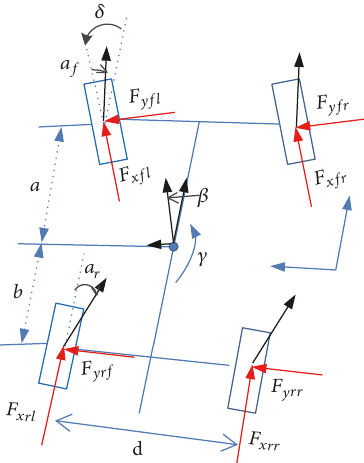
Figure 1: Bus rollover dynamic model.